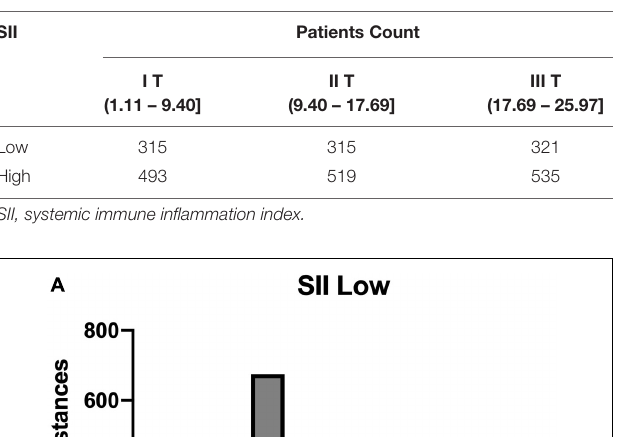
TABLE 5 | The number of patients divided according to the Vitamin D levels in terms of SII.